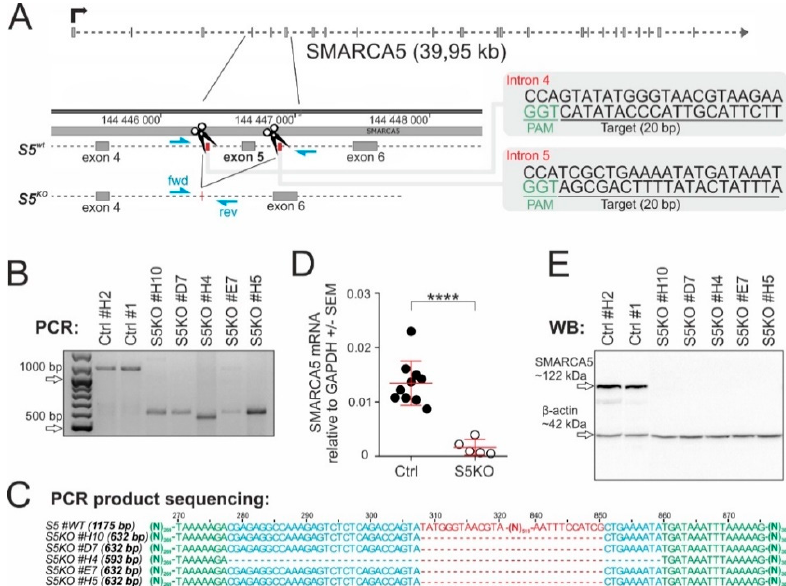
Figure 2. Inactivation of SMARCA5 gene expression (S5KO) in AML cells. ( A ) Scheme of generating the S5KO using CRISPR/Cas9 technology. The Cas9 nuclease was targeted into two intronic sites (scissors) surrounding exon5 of the SMARCA5 gene. The sequences of guide RNAs are depicted in gray boxes on the right. Indicated are exons 4-6 (small rectangles) and genotyping primers (blue arrowheads). ( B ) PCR verification of the exon5 deletion in the indicated S5KO clones. ( C ) Analysis of SMARCA5 gene region following the Cas9 nuclease deletion. PCR products (same as in B) were Sanger-sequenced and aligned with the wt sequence using the Kalign web tool. After sequencing, the precise length of the resultant PCR amplified region was determined (on the left in brackets). ( D ) Quantitative PCR analysis of SMARCA5 mRNA expression in the S5KO clones ( n = 5) compared to controls ( n = 10). Data normalized to the GAPDH mRNA. Student’s t-test, p < 0.00001 ****. ( E ) Immunoblotting of SMARCA5 expression in CRISPR/Cas9-treated K562 or controls. β -actin controlled the load.